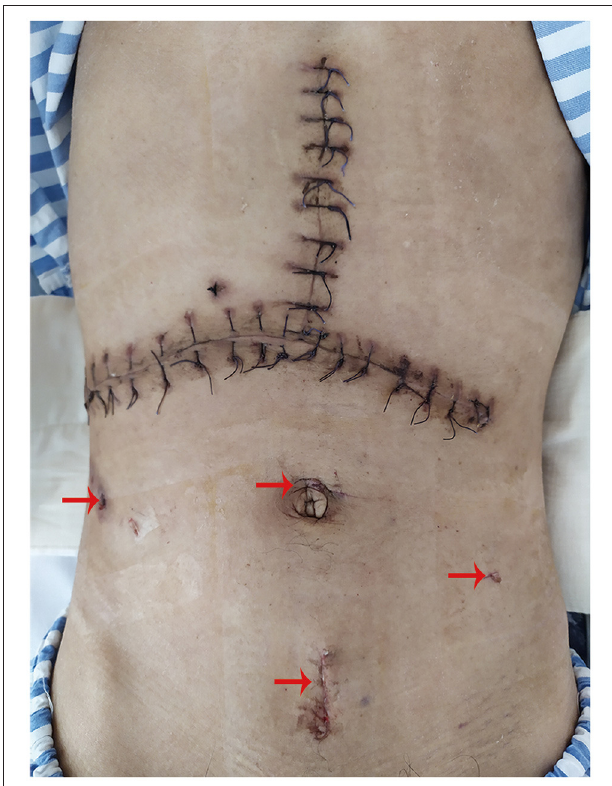
FIGURE 3 | Small incisions (indicated by red arrow above) derived from laparoscopy and an inverted T-shape surgical incision caused by liver transplantation were revealed